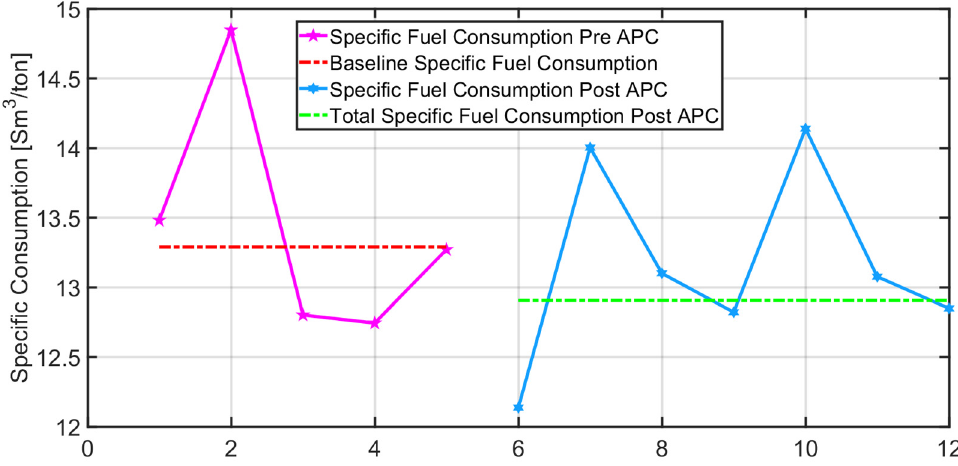
Figure 15. Control results: pre/post-APC system comparison on speci fi c fuel consumption consid- ering di ff erent production periods. ing different production